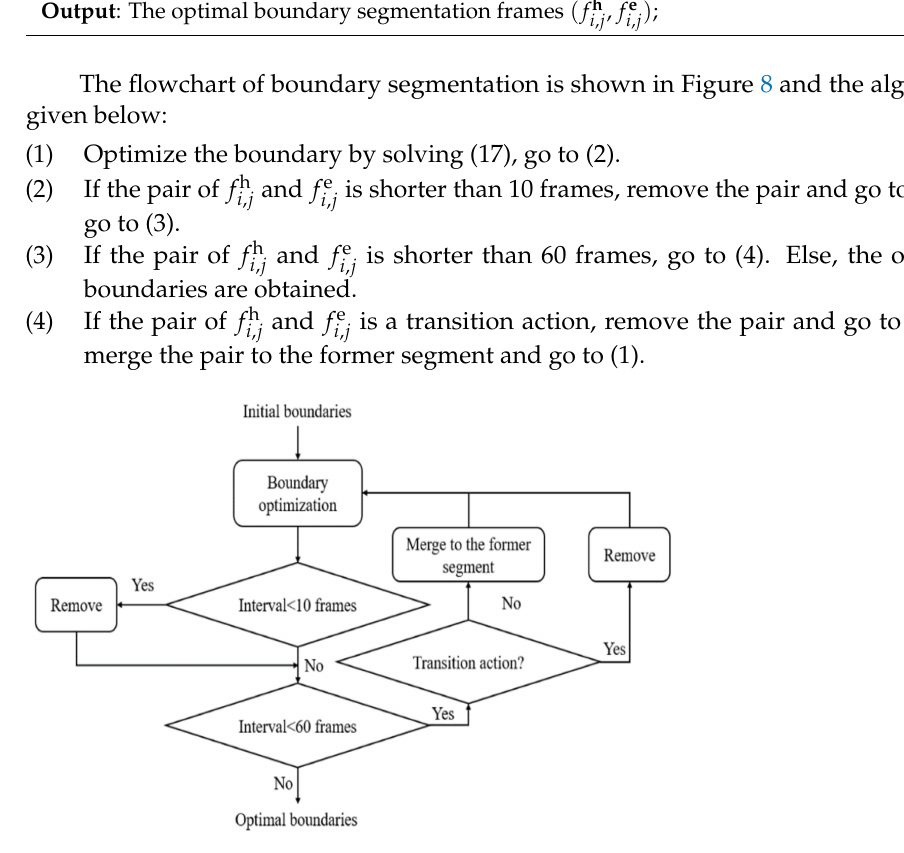
Figure 8. The algorithm of boundary